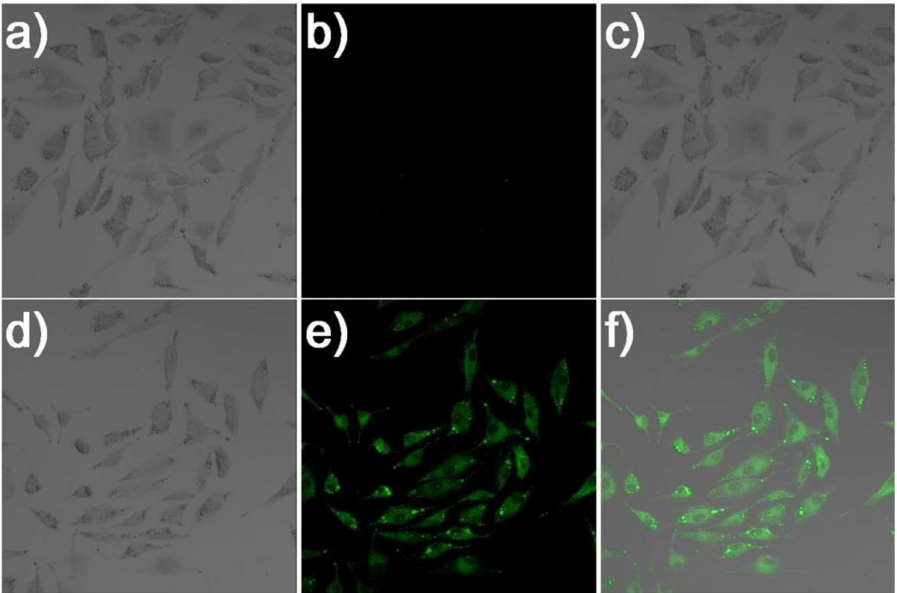
Figure 6. Confocal fluorescence contrast images: bright image ( a , d ) fluorescence image ( b , e ) and overlay image ( c , f ). Top row: Living A549 cells pretreated with 1.0 mM NEM and then incubated with probe 1 ; bottom row: living A549 cells only incubated with probe 1 for 30 min at 37 ◦